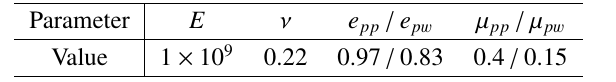
Figure 2. Normalized flow rate Q / Q 0 as a function of the vibra- Figure 1. (a) Side view of the experimental setup and close-up tion amplitude A in experiment and simulation for a frequency of the opening ( D = 10 mm on the picture). (b) Snapshot of f = 30 Hz and an opening size D ∼ 10 mm. Two di ff erent the simulated system with the same geometry as the experiment. regimes are observed for the flow rate depending on the ampli- Particles are colored in order of insertion, from blue to red. tude. To illustrate, typical profiles of mean relative velocity | v | near the silo opening are presented for those regimes and without Table 1. Particle properties used in the simulation: Young vibration in simulation (Note: the relative velocities are always measured in the referential of the silo: v = v absolute − v silo modulus E and coe ffi cients of Poisson ν , restitution e and friction µ . The subscripts pp and p w indicate particle-particle and particle-wall contacts, respectively.